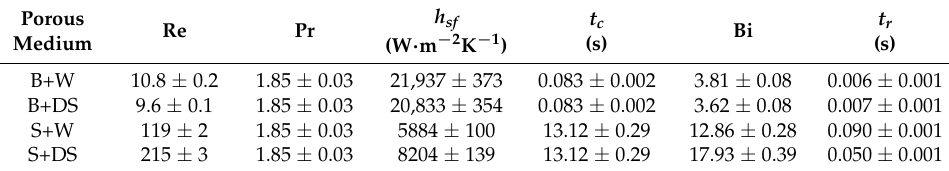
Table 6. Results obtained on the condition of maximum velocity of the liquid in the